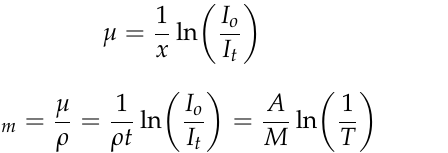
where 𝜇 (cm − 1 ) denotes the LAC, 𝜌 (g · cm − 3 ) is the density, 𝑥 (cm) and 𝑡 (g·cm − 2 ) are the physical thickness and mass thickness (mass per unit area), T is the transmittance, M (g) is the mass of the sample material, A is the cross-sectional area (cm 2 ), and 𝜇 (cid:3040) (cm 2 g − 1 ) indicates the total MAC. The total 𝜇 (cid:3040) values were calculated on the basis of the mixture rule by using the weight fraction ( 𝜔 (cid:3036) ) for each element i of the particleboard materials, as expressed in Equations (5) and (6):